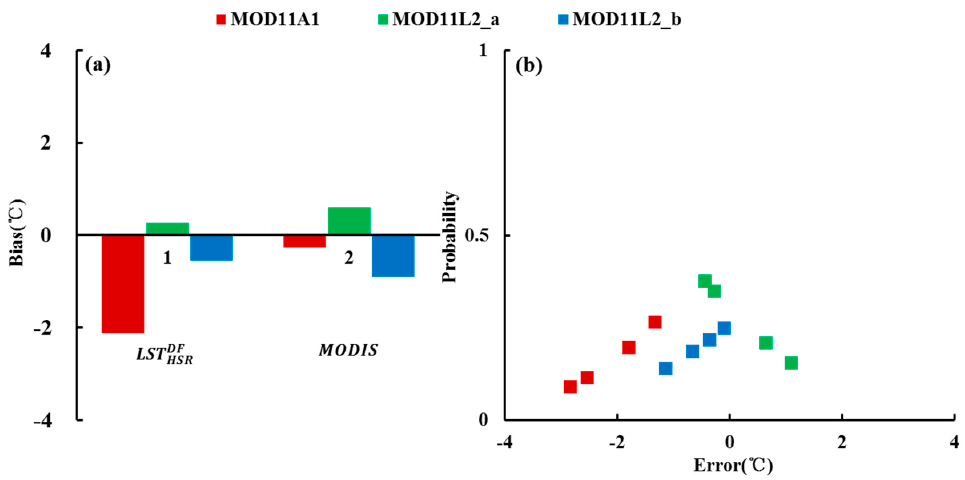
Figure 8. The results of MODIS LST product and its fused LST compared with in situ observations on 13 September 2015. ( a ) bias Histogram and ( b ) fusion error probability distribution.